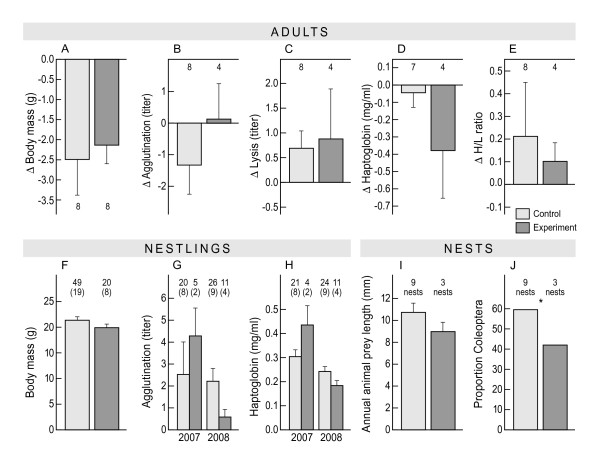
Short-term (within-brood) effects of an experimental handicap on the trade-off between reproduction and self-maintenance in skylarks. A) – E) Adult body mass and immune parameters. Values are expressed as the difference between the baseline measure taken when their nestlings were small, and the final measure taken when their nestlings were about to fledge. F) – H) Nestling body mass and immune measures from control and experimental parents; the latter were assigned to treatment groups 0-7 days earlier. I) Average length of animal prey in droppings of nestling skylarks. J) Proportion of the main prey type (beetles, order Coleoptera) in the diet of nestlings. Bars depict mean and standard error. Numbers represent sample size of individual birds. For nestlings the number of nests is given in parentheses. Stars denote statistically significant differences. If both years are plotted the interaction between year and treatment was significant. Statistical analyses can be found in Results and Additional file 1: Table S1.